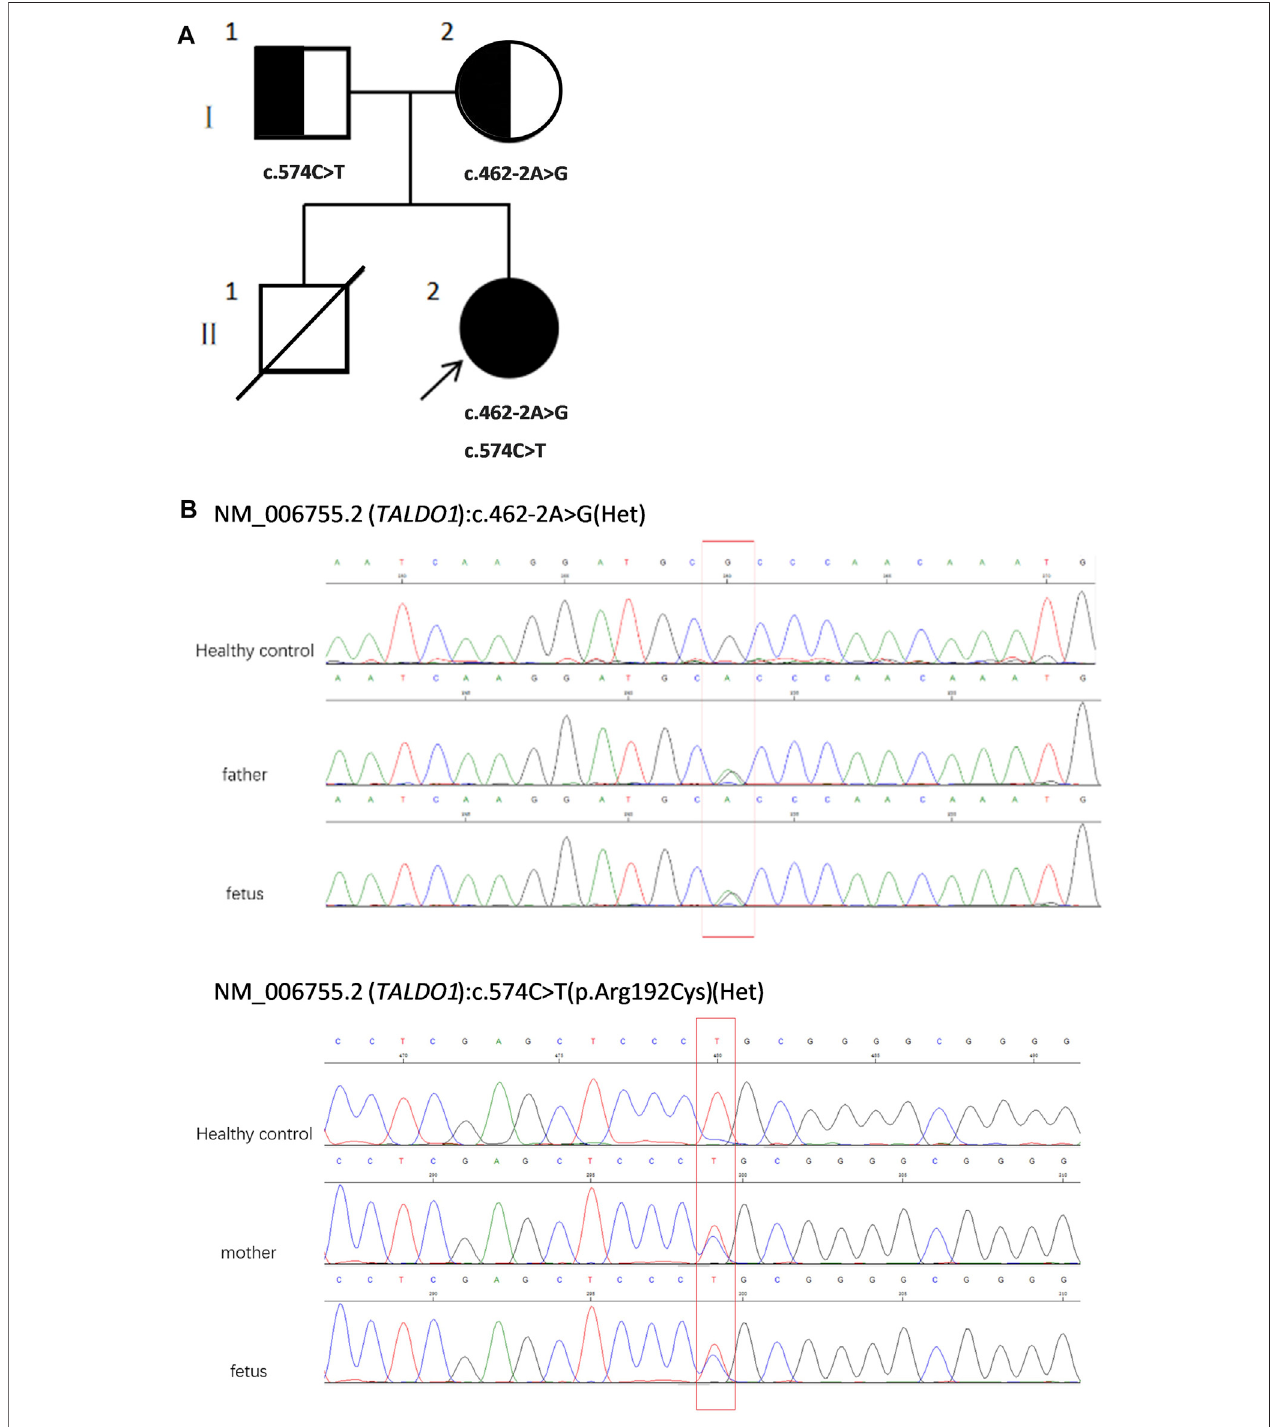
FIGURE1|(A) Pedigreeofthefamily. (B) Sequencingof TALDO1 gene(referencecDNAsequence,NM_006755.2)revealedtwoheterozygousvariations,resulting in A to G splicing at nucleotide position 462 – 2 (c.462-2A > G) and C to T substitution at nucleotide position 574 [c.574C > T(p.Arg192Cyrs)]. Het, heterozygous.